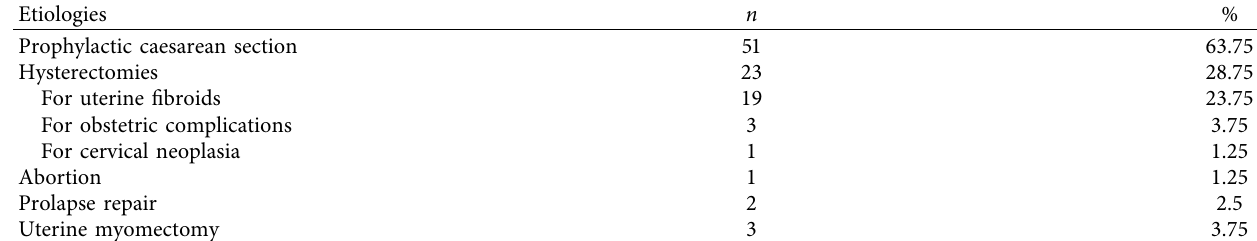
Table 3: Etiologies of iatrogenic fistulas.